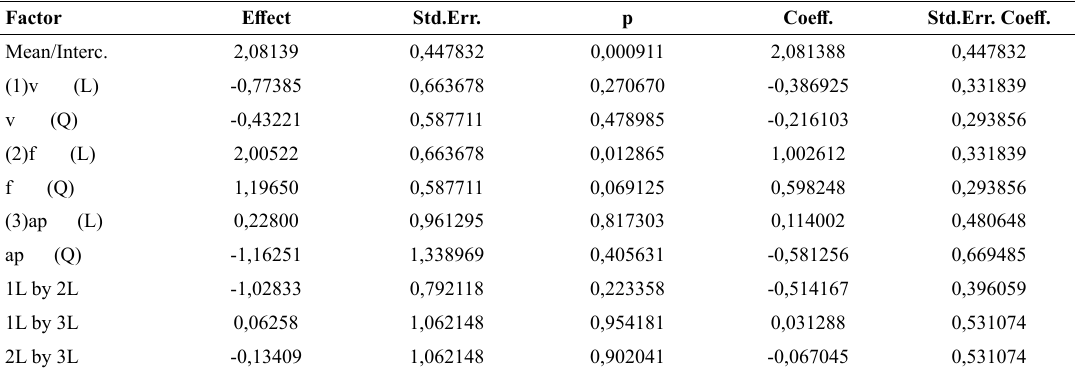
Table 9. ANOVA for the effect of the independent variables on white layer. Factor Effect Std.Err. p Coeff. Std.Err. Coeff.